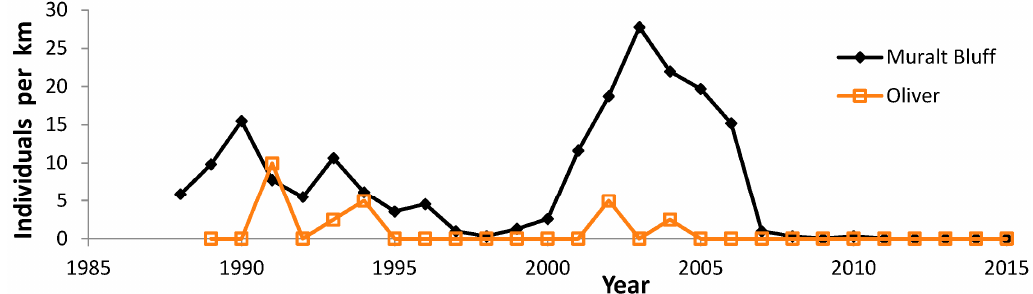
Figure 2. Regal fritillary individuals per km on peak survey per year at Muralt Bluff and Oliver Prairies in Green County.